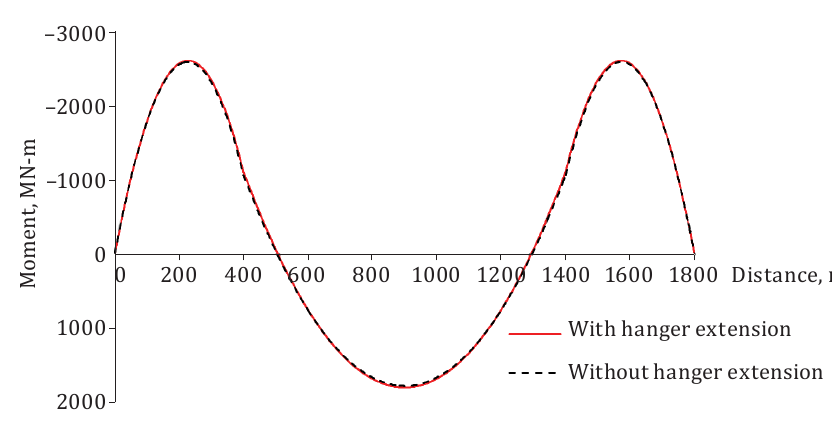
0 Figure 4. Hanger tension increment of the self-anchored suspension bridge